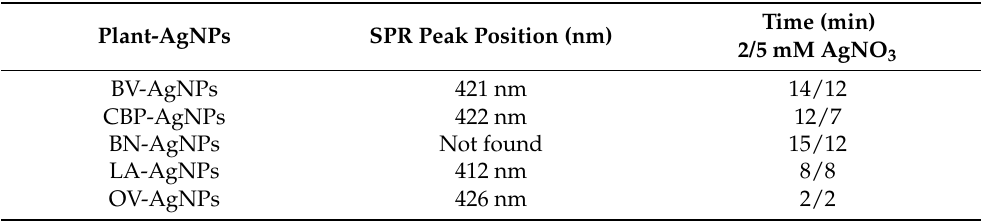
Table 3. The surface plasmon resonance (SPR) peak position and reaction time for corresponding plant extract/AgNO 3